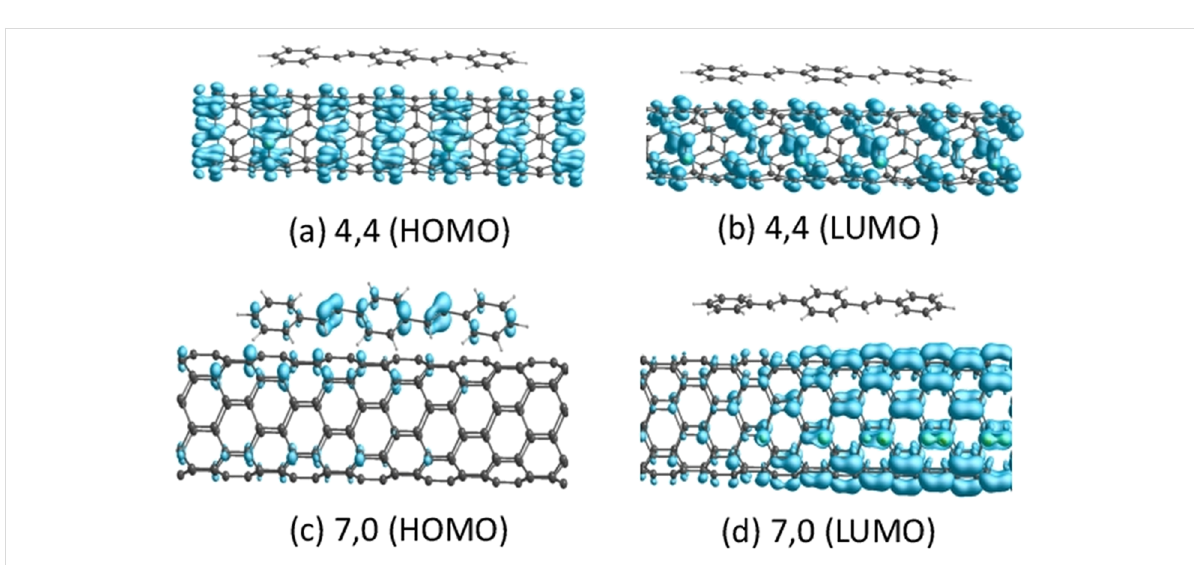
Figure 3: Wavefunction isosurface plots of HOMO and LUMO states for (a,b) (4,4) and (c,d) (7,0) carbon nanotubes interacting with triphenyl PPV oligomer.